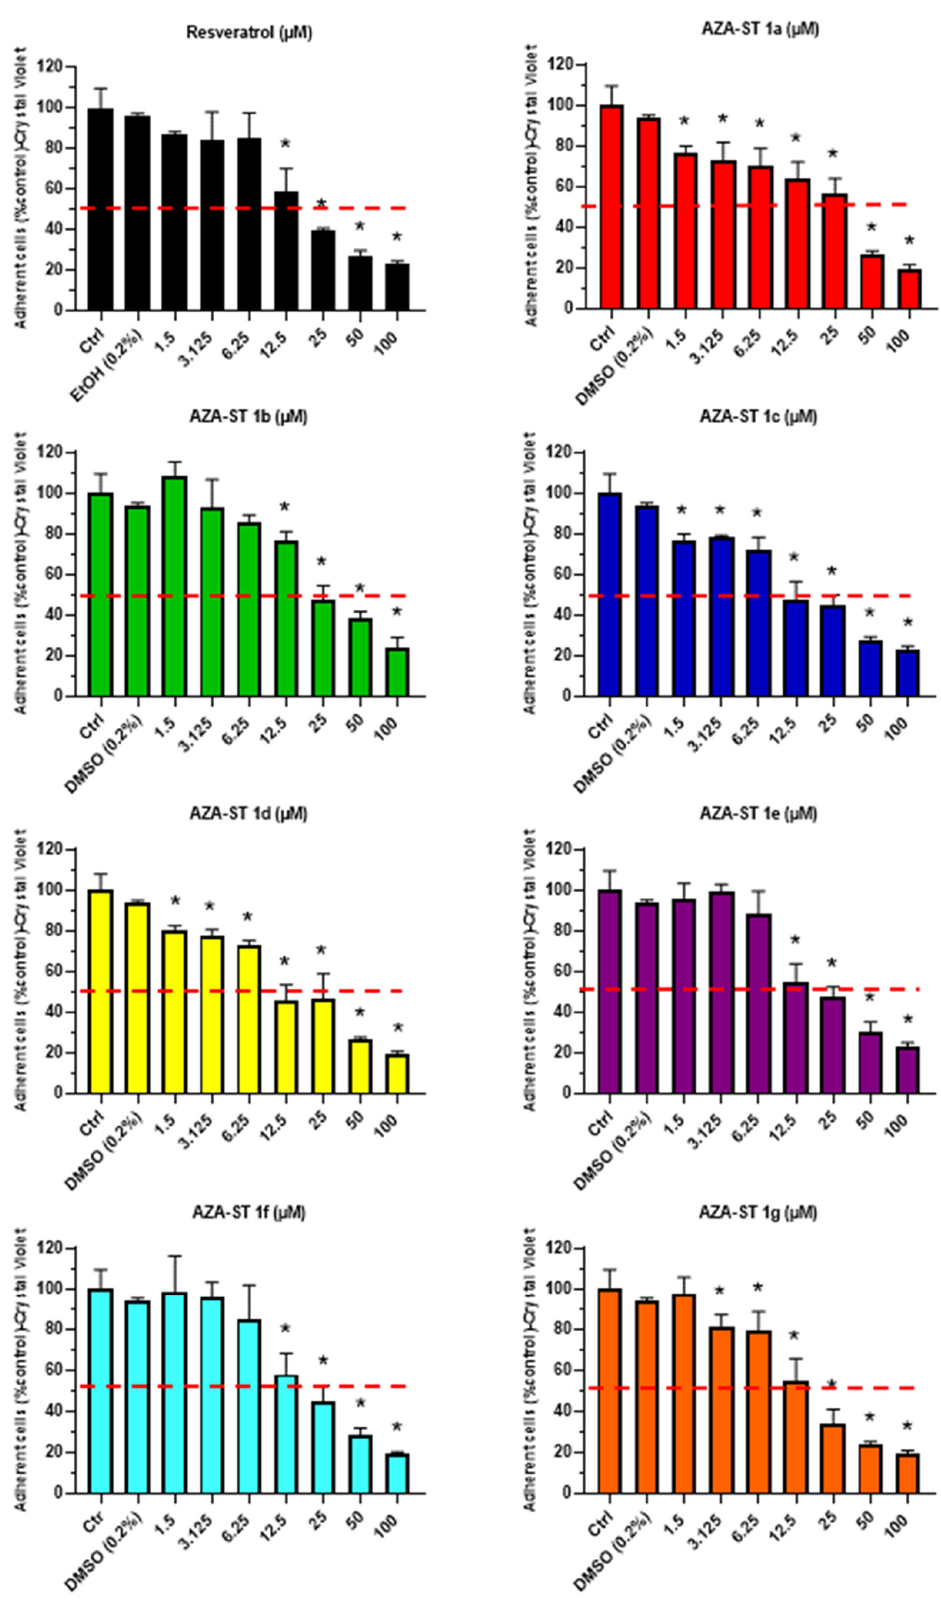
Figure 3. Crystal violet assay evaluation of the effects of AZA-ST 1a–g and resveratrol on cell growth. N2a cells were incubated for 24 h with or without AZA-ST 1a–g or resveratrol ( trans -resveratrol) in a range of concentrations from 1.5 to 100 µ M. The dotted red line makes it possible to evaluate the